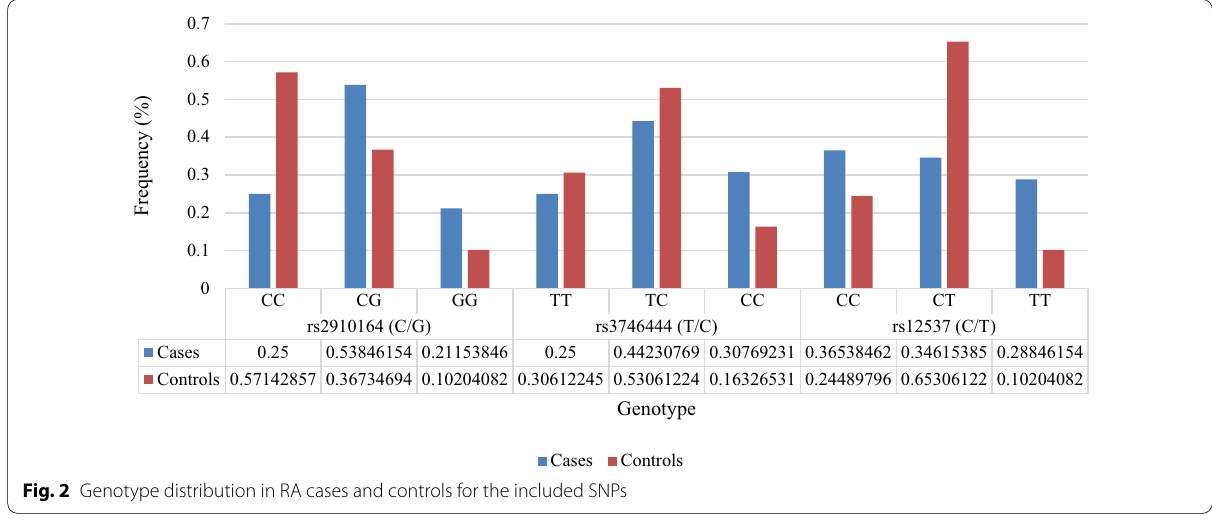
Fig. 2 Genotype distribution in RA cases and controls for the included SNPs